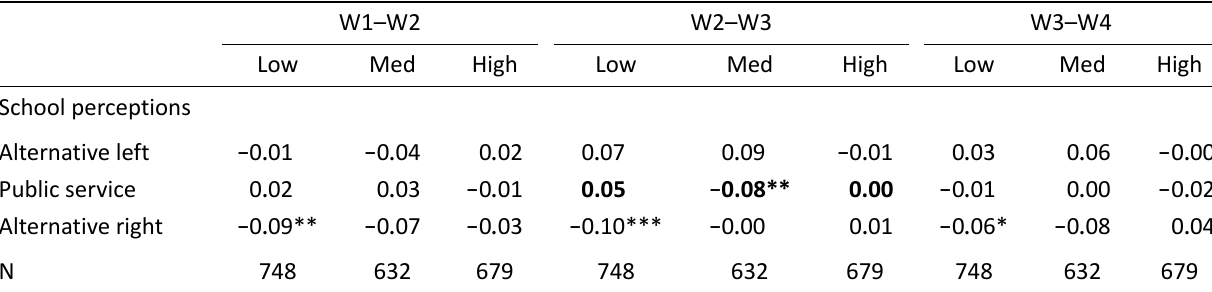
Figure 3. Path model predicting perceptions of Swedish school. Notes: Path estimates are unstandardized coefficients from three separate SEM models (W2, W3, and W4); each media use equation controls for gender, age, political interest, and ) ; W2 Model—N = 2,279, 𝜒 2 (5) = 39.203, p = 0.000, ideology; school equation controls for the lagged dependent variable ( t − 1 RMSEA = 0.055, CFI = 0.985; W3 Model—N = 2,325, 𝜒 2 (5) = 38.246, p = 0.000, RMSEA = 0.053, CFI = 0.984; W4 Model— N = 2,316; 𝜒 2 (5) = 28.135, p = 0.000; RMSEA = 0.045; CFI = 0.988; * = p < 0.05; ** = p < 0.01 ; *** = p < 0.001. Table 2. Multiple group comparison across levels of media trust (unstandardized